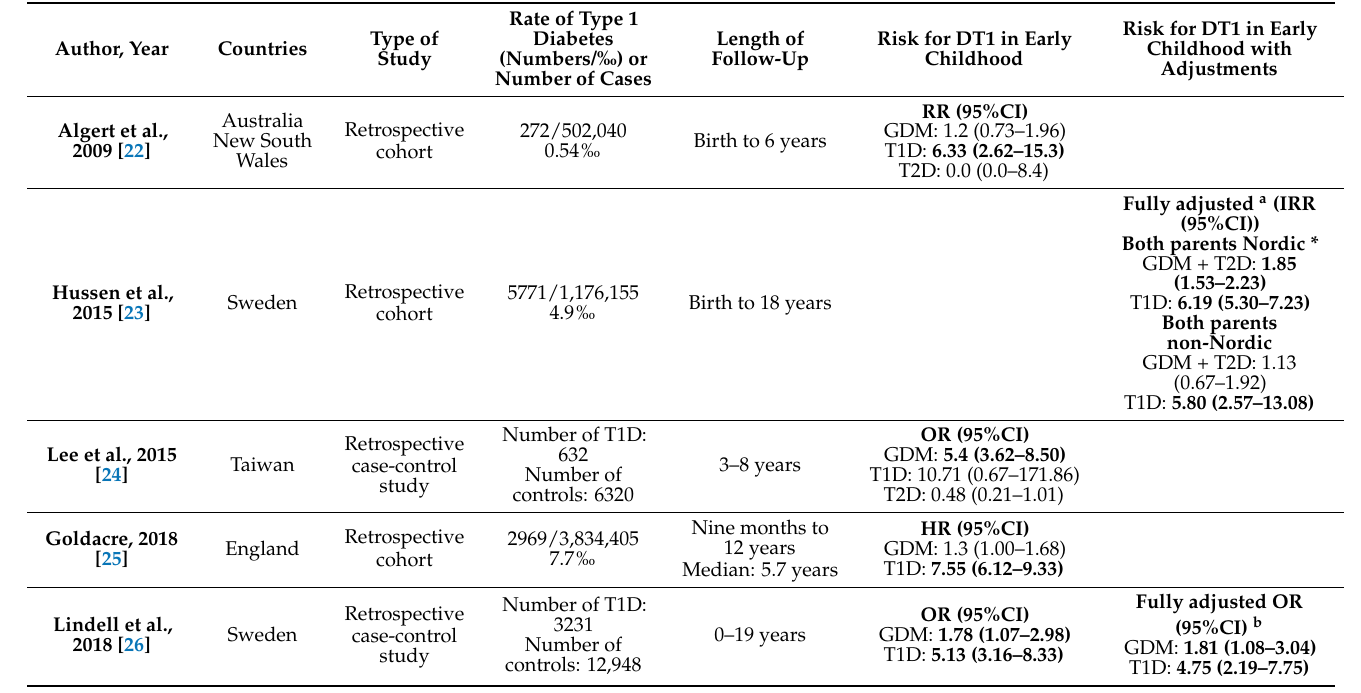
Table 3. Risk for type 1 diabetes in offspring according to the type of maternal diabetes during